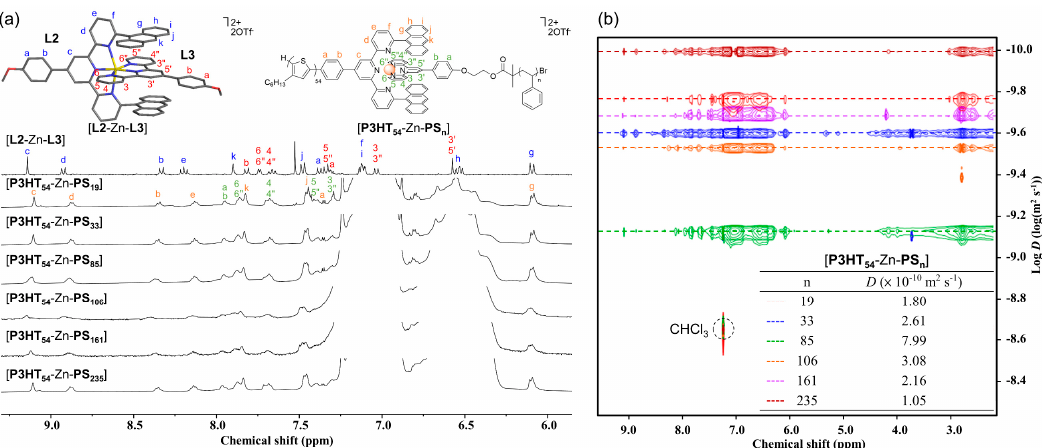
Figure 2. ( a ) Synthesis of P3HT 54 . Reagents and conditions : (i) 1) t -BuMgCl, LiCl, tetrahydrofuran (THF), 2) Ni(dppp)Cl 2 , THF, 0 °C; (ii) 6,6"-dianthracenyl-4'-(4-boronophenyl)tpy, Pd(PPh 3 ) 4 , NaOH, THF/H 2 O (3/1, v/v), reflux. ( b ) 1 H NMR spectra of ligand L1 and P3HT 54 .